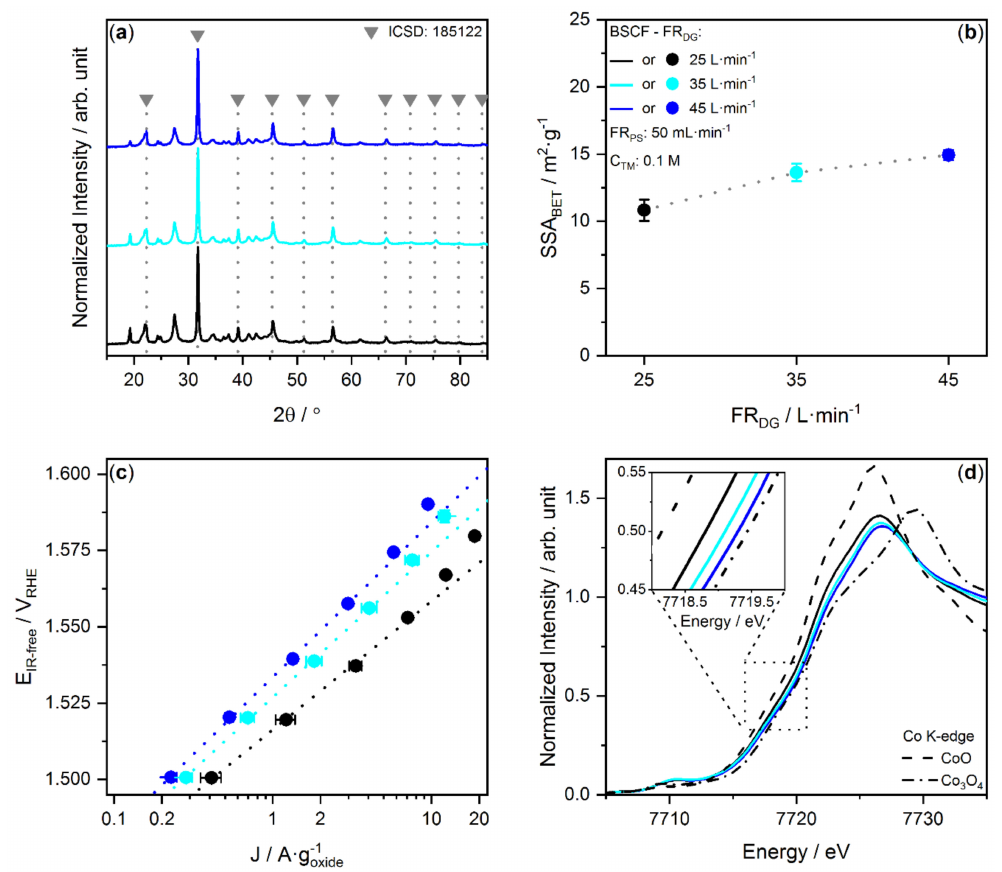
Figure 4. Summary of the influence of the flow rate of the dispersion gas (FR DG ) in the range of 25 ( — or • ), 35 ( — or • ) and 45 L · min − 1 ( — or • ) on flame spray synthesized BSCF: ( a ) Powder XRD patterns ( (cid:72) ICSD reference of BSCF: 185122); ( b ) SSA BET ; ( c ) Tafel plot of the OER activities with linear fit (dotted line); ( d ) Co K-edge XANES spectra of the as-synthesized BSCF batches (standards: CoO ( – – ) and Co 3 O 4 ( – • – )). For all cases: FR PS = 50 mL · min − 1 and C TM = 0.1